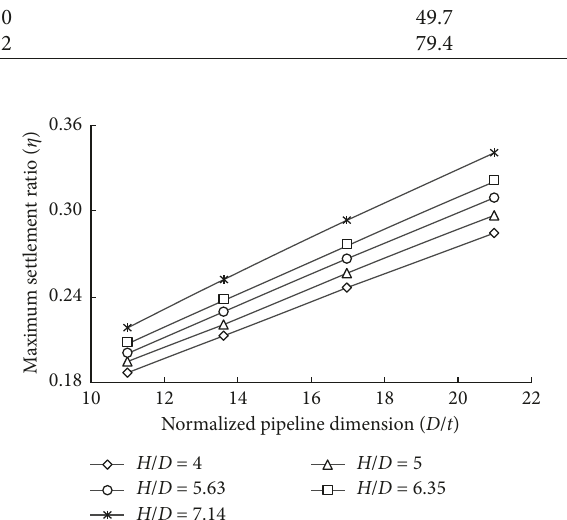
Figure 4: Influence of pipeline dimension on the maximum set- tlement ratio.